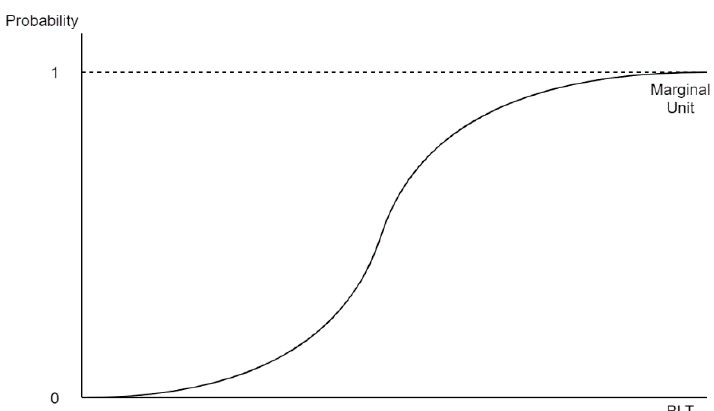
Figure 5. BLT probability curve.